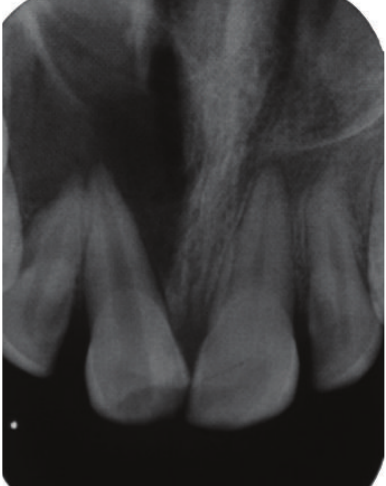
Figure 28: Pre-operative IOPA radiograph showing well-defined large periapical lesion.